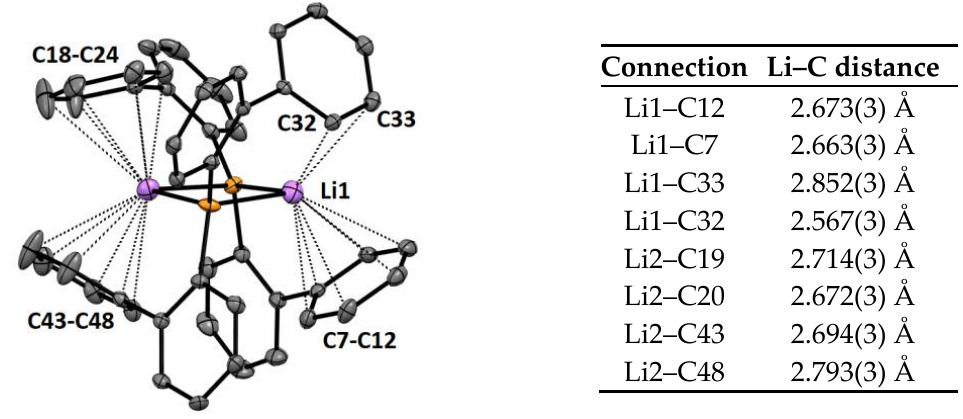
Figure 2. Overview of isolated crystal structure of the phosphide E and close contacts of the lithium atom with various carbon atoms. The hydrogen atoms were omitted for clarity. Inset: Close lithium- carbon distances which indicate non-bonding interactions.